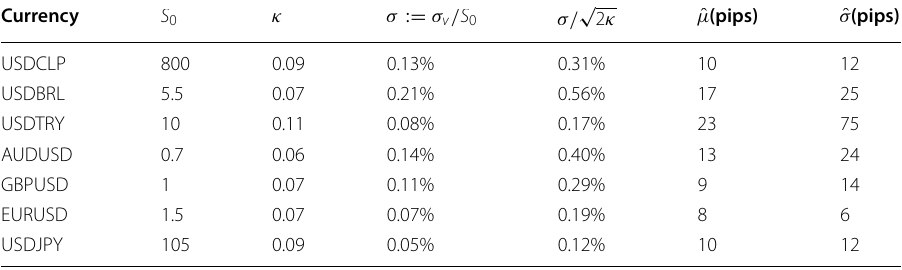
Table 1 Estimates of parameters κ and σ v defining the mean‑reverting process in (12) are obtained from a sample containing 15‑min intraday prices from 9 a.m. to 2 p.m. within the period